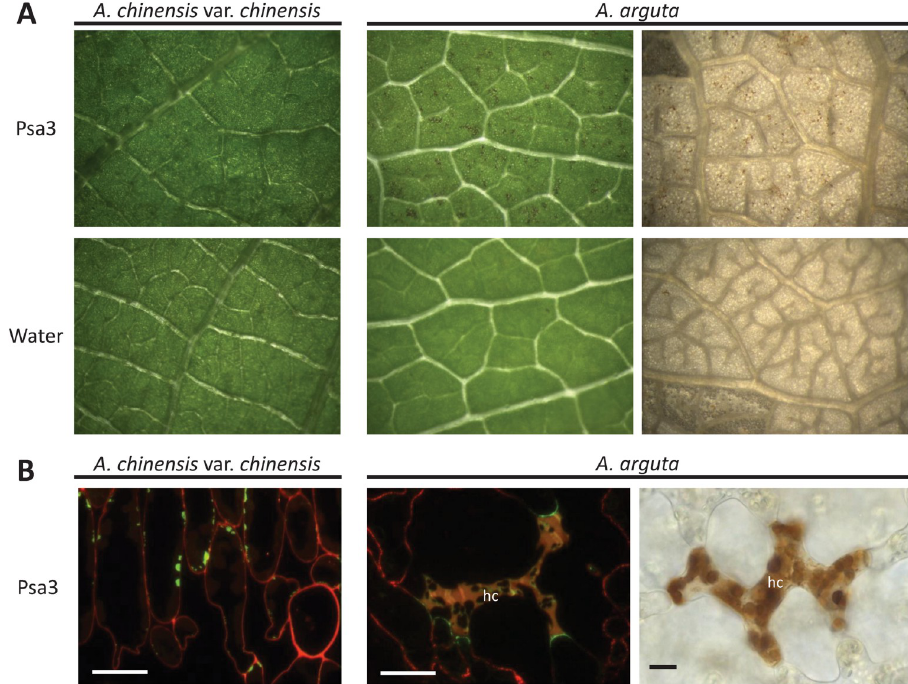
Fig 1. Pseudomonas syringae pv. actinidiae biovar3 (Psa3) induces the hypersensitive response in Actinidia arguta . A . arguta and A . chinensis var. chinensis leaves displaying symptoms following infection with Psa3 V-13 at 1 day post-infection (dpi) in A . arguta and 5 dpi in A . chinensis var. chinensis . (A) Visualization of macroscopically visible localized cell death indicative of a hypersensitive response (HR) in leaves of A . arguta , in contrast to A . chinensis var. chinensis , spray-infected with Psa3 V-13 at 10 8 cfu/mL or water control (left). A . arguta leaves were cleared in acetic acid:ethanol to better visualize brown phenolic compounds indicating cell death (right; brown speckling in the images). Images were viewed under a binocular microscope at 2x magnification, except for the top right image which was at 4x magnification. (B) Fluorescence microscopy of Psa3 V-13-infected A . arguta and A . chinensis var. chinensis mesophyll tissue. Callose ( β 1-3-glucan) is immuno-labelled and fluorescence indicated in green; cell wall pectin is immuno-labeled and fluorescence indicated in red; yellow coloring is accumulation of phenolic compounds in cells showing hypersensitive cell death (hc; left) and loss of cell wall integrity. Bright field microscopy of cleared A . arguta leaf in A indicates phenolic compound accumulation in cells showing hypersensitive cell death (hc; right) caused by cell wall breakdown. Scale bars represent 10 μ